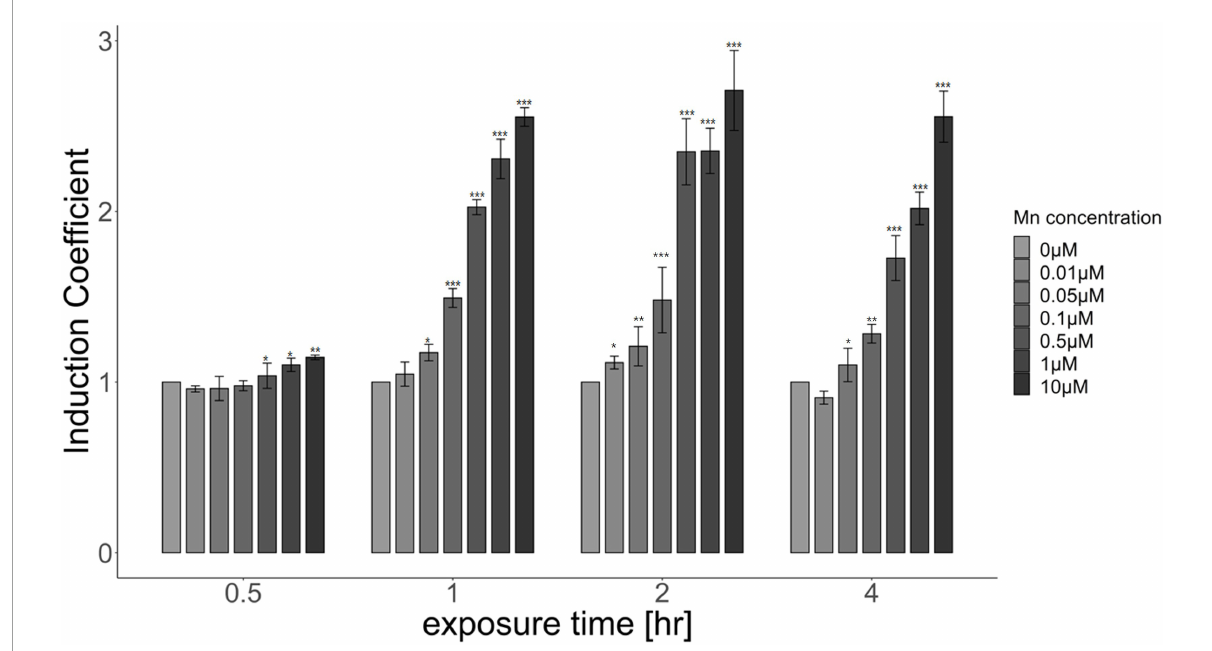
FIGURE3 Responses of Escherichia coli cell-based biosensors harboring pMntS-eGFP upon Mn(II) exposure. The biosensors were exposed to different Mn(II) concentrations, and the induction coefficient values were measured after 0.5, 1, 2, and 4 h of exposure. The data was obtained from more than three times of replicated experiments. The asterisks indicate that the treatment values were higher than the control values (Dunnett’s test, * p < 0.05, ** p < 0.01, and *** p < 0.001).